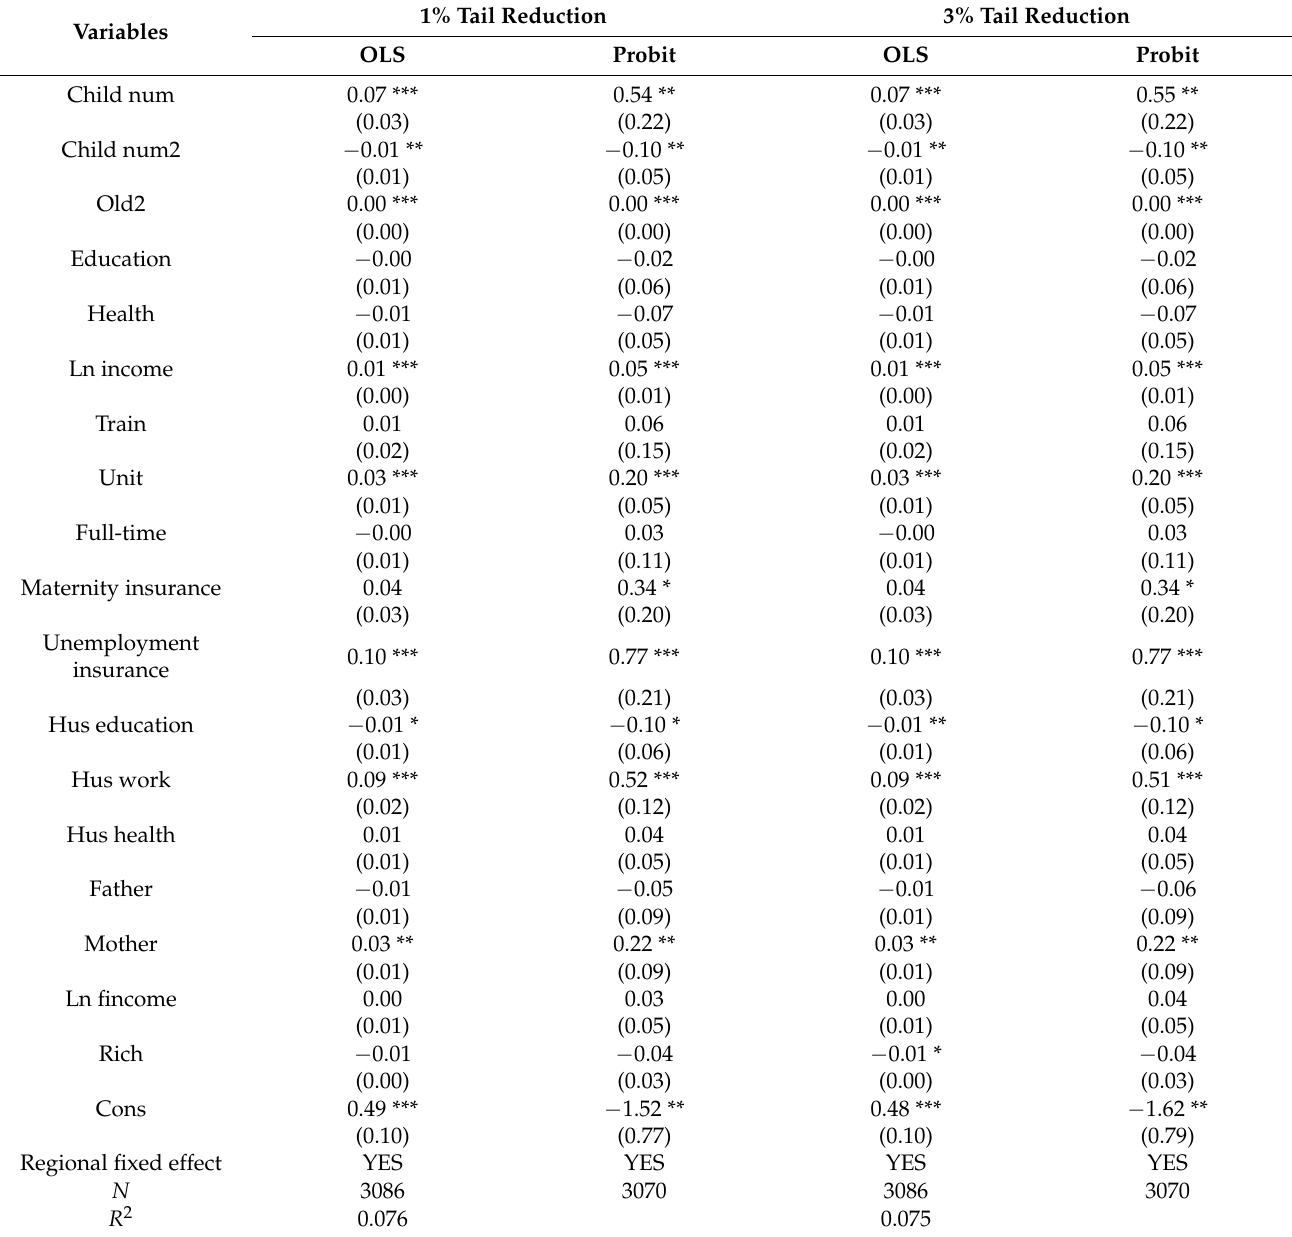
Table 6. Robustness regression results after tailing